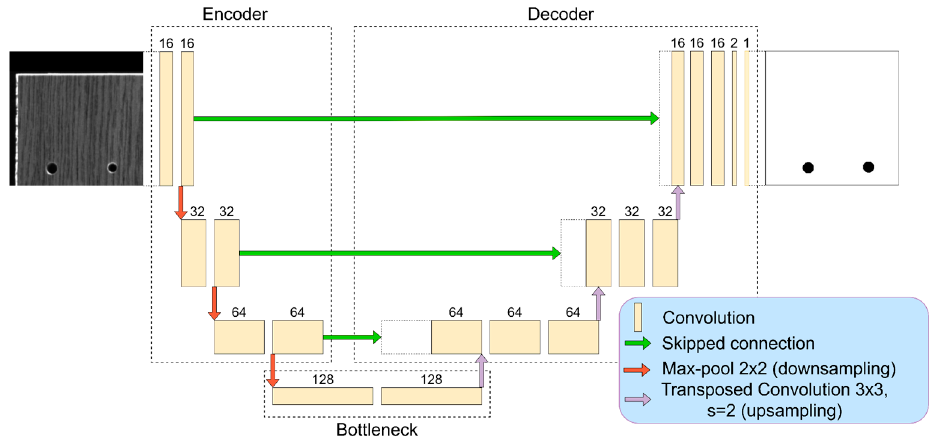
Figure 1. Baseline U-Net principal structure. The input is 320 × 320 px greyscale image and the output 320 × 320 px classified image (black is drilling segmentation, white is the background).